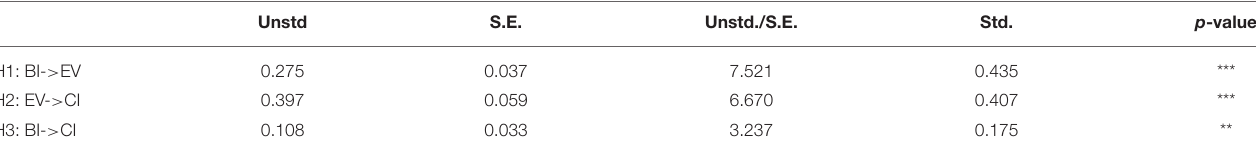
TABLE 5 | Regression coefficient. Unstd S.E. Unstd./S.E.